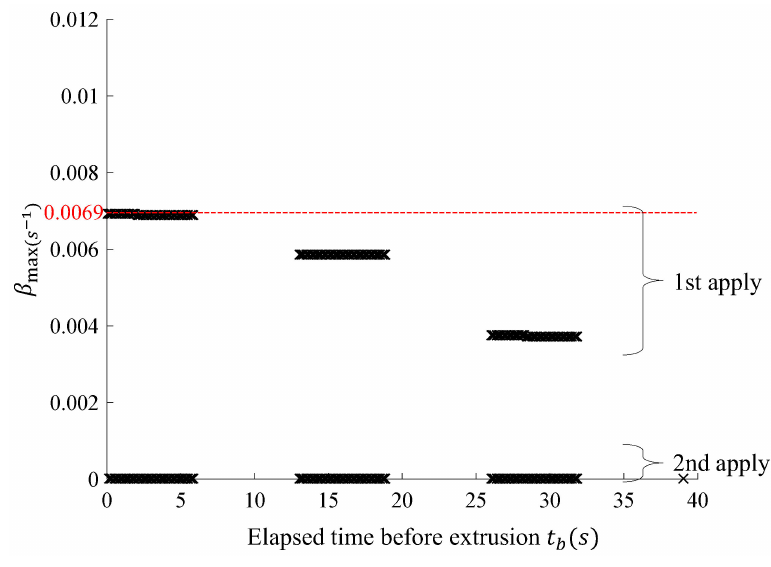
Figure 12. t b − β max